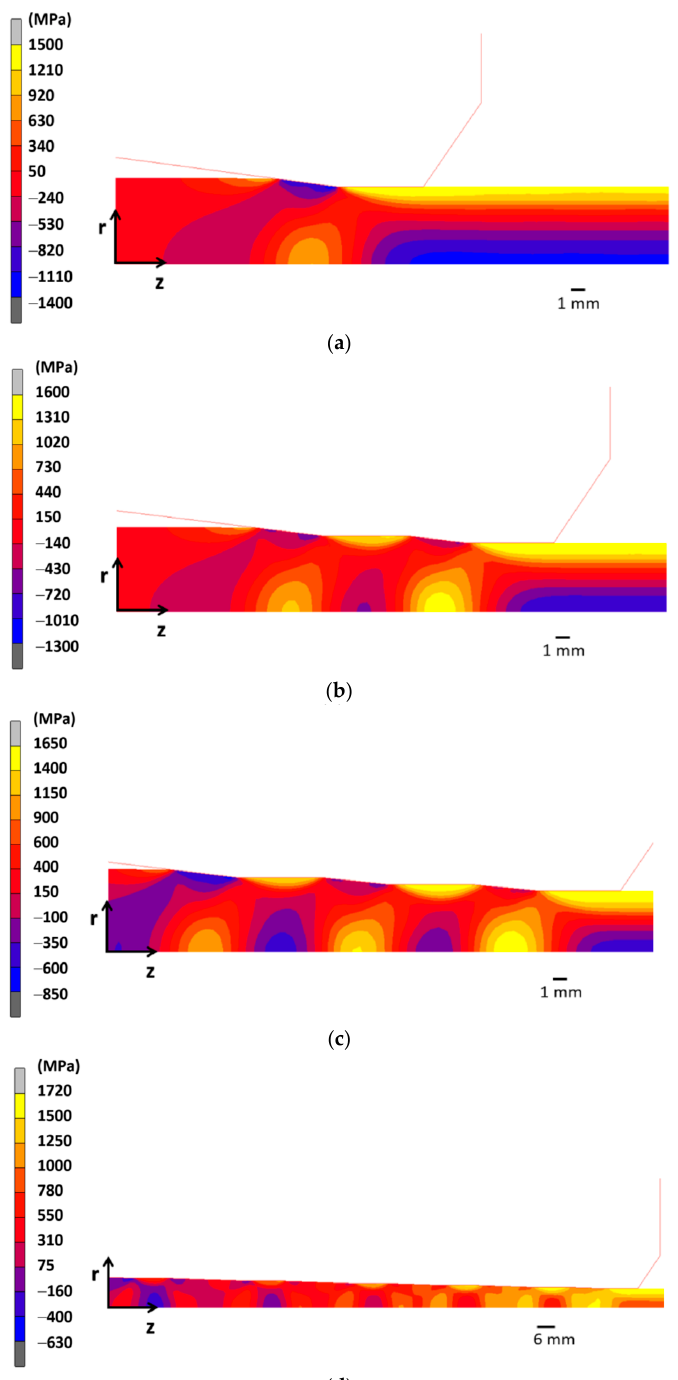
Figure 7. Axial stress fields during wire diameter reduction: ( a ) one reduction per die (conventional wire drawing), ( b ) two reductions per die, ( c ) three reductions per die, and ( d ) six reductions per die.